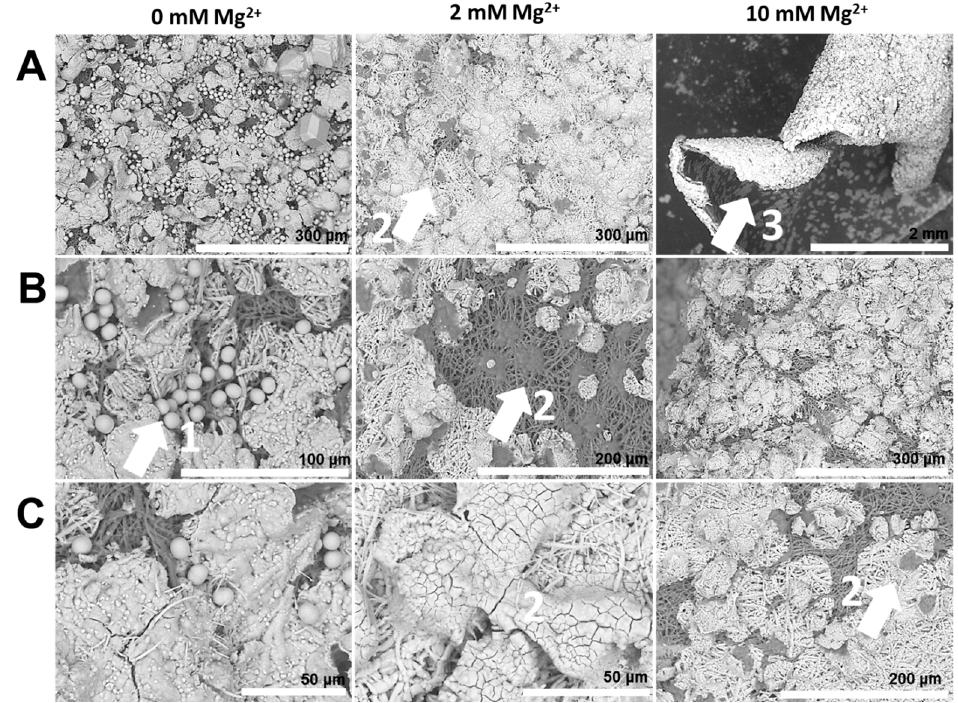
Figure 14. Representative SEM images of outer surfaces of shell membranes mineralized in the presence of PSS- co -MA (50 ppm) and different Mg 2+ contents. Arrows indicate (1) spherical particles formed in the absence of Mg 2+ ions, (2) a higher degree of mineralization of collagen fibrils relative to mammillae and (3) distinct mineralization on inner and outer membrane surfaces.